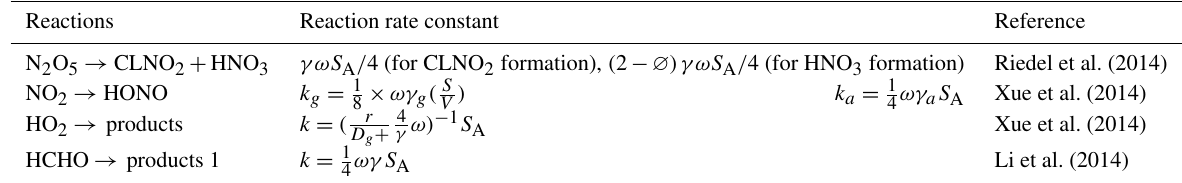
Table 2. Heterogeneous reactions and associated rate constants used in the OBM model.